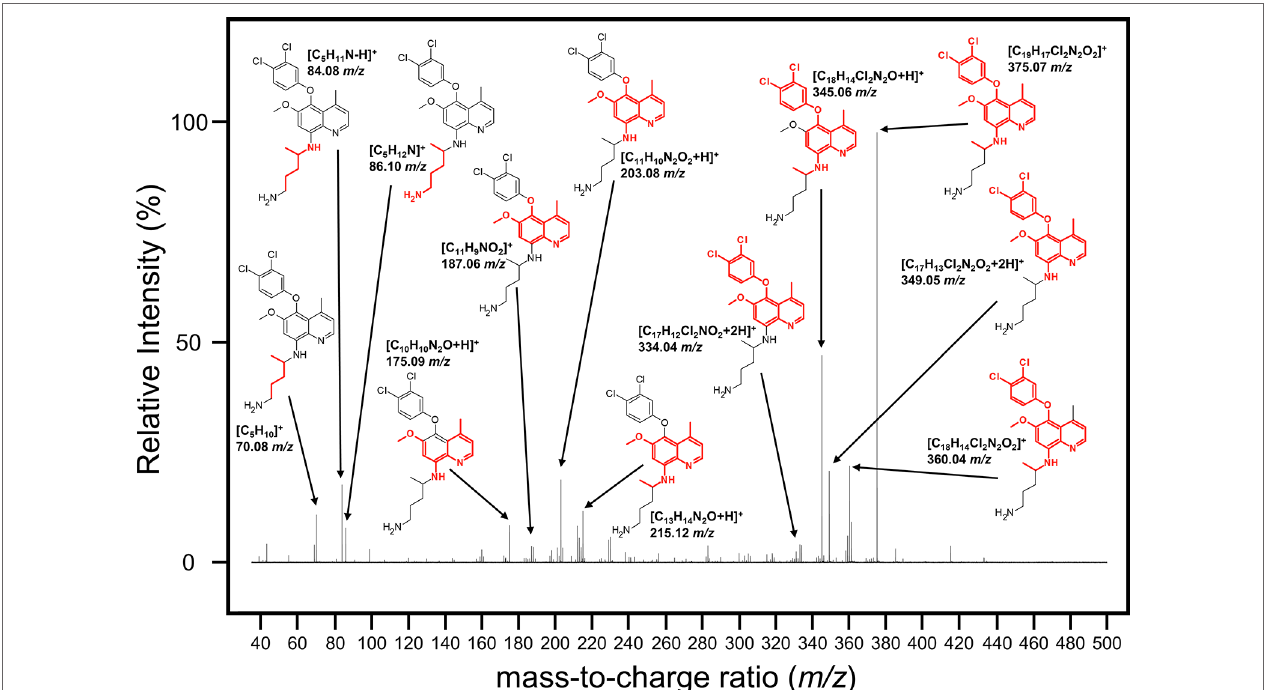
FIGURE 5 | Mass spectrum showing the fragmentation pattern of NPC1161B annotated with the m/z and predicted chemical formula with structure. The structure of NPC1161B is shown with the red region denoting the predicted fragment that matches to a given ion.